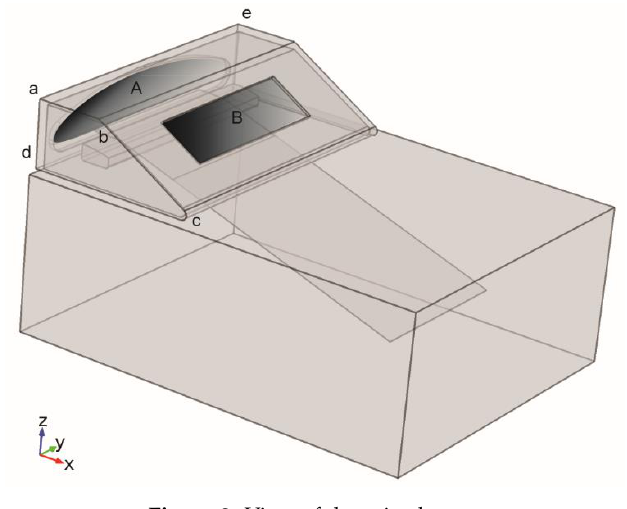
Figure 2. View of domain shapes. Table 1. Geometry specifications of the sealed metal box (mm). The distances are defined in Figure 2.